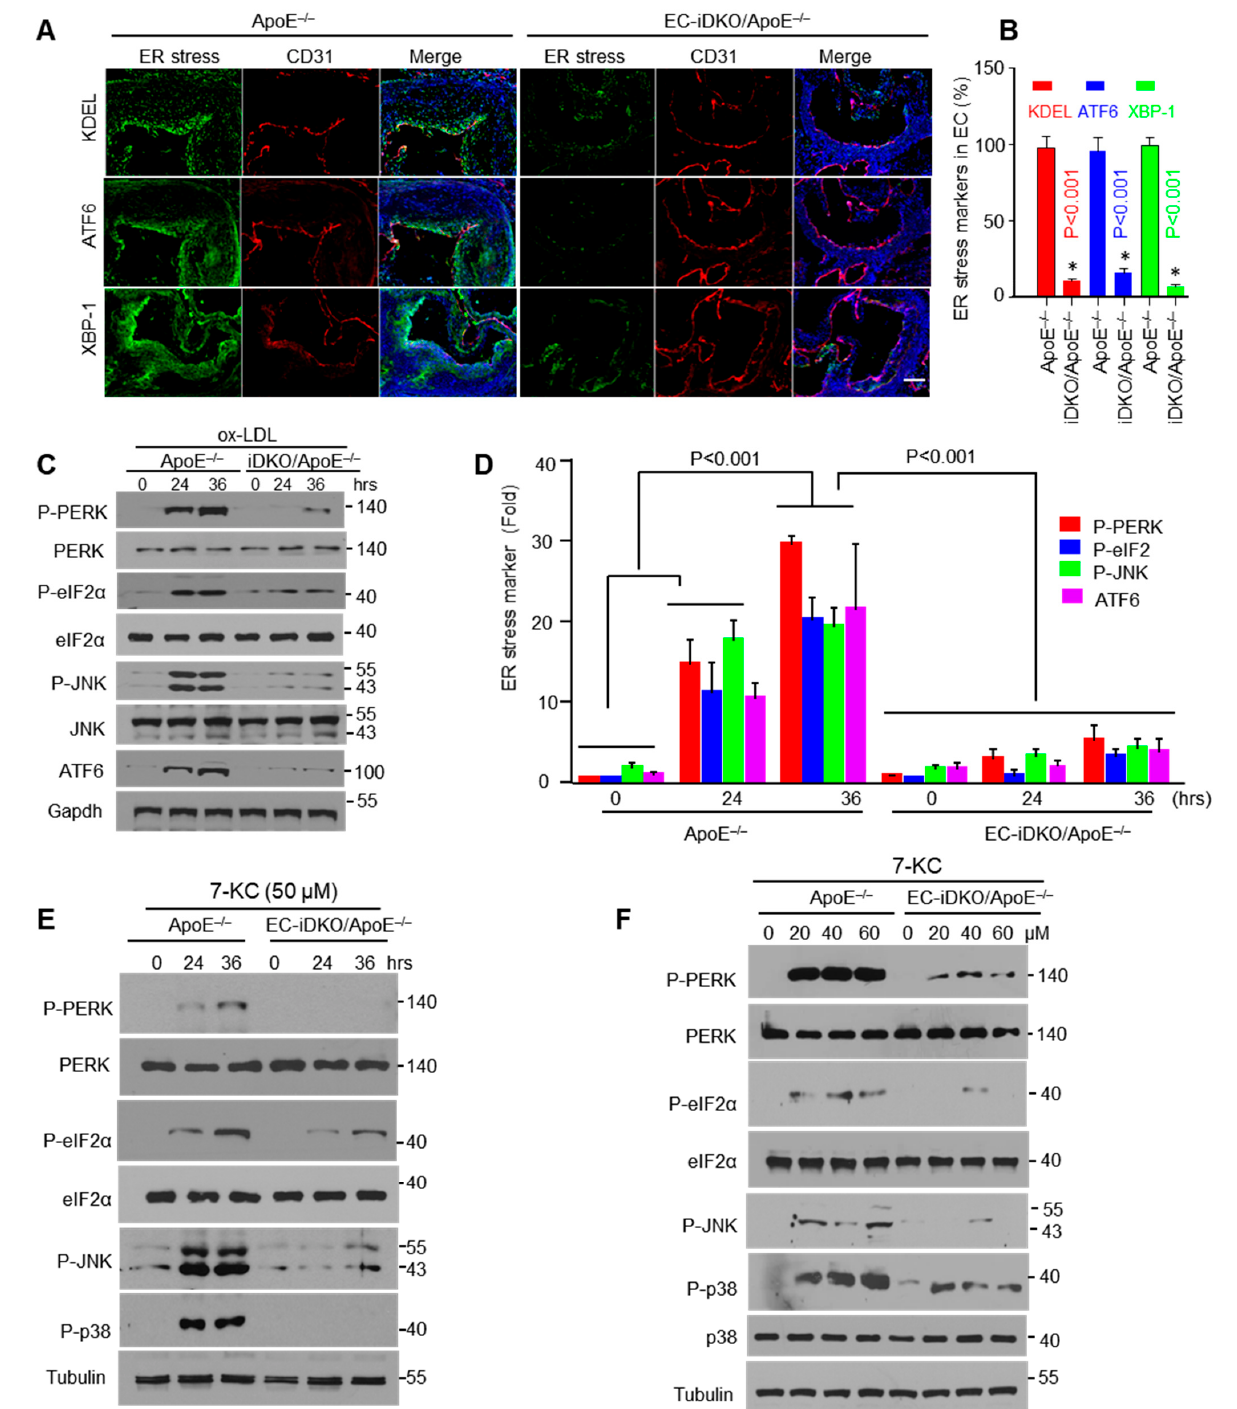
Figure 2. Loss of endothelial epsins attenuates ER stress-induced inflammatory signaling. ( A ) Comparison of endothelium ER stress markers in the aortic roots of ApoE − / − or EC-iDKO/ApoE − / − mice by immunofluorescence staining. CD31 served as an endothelium marker (n = 5 in each group). Scale bar = 500 µm. ( B ) Quantification of ER stress markers from A. * ApoE − / − vs . EC-iDKO/ApoE − / − . ( C ) MAECs were isolated from ApoE − / − or EC-iDKO/ApoE − / − mice, followed by treatment with ox-LDL at 100 µg/mL for the indicated times. Cell lysates were subjected to Western blot analyses using the specified antibodies. ( D ) Quantification of results from C (n = 5). ( E , F ) MAECs with or without epsins were treated with 7-KC for various times and concentrations as indicated, and ER stress markers were assessed by Western blot analysis (n = 3).